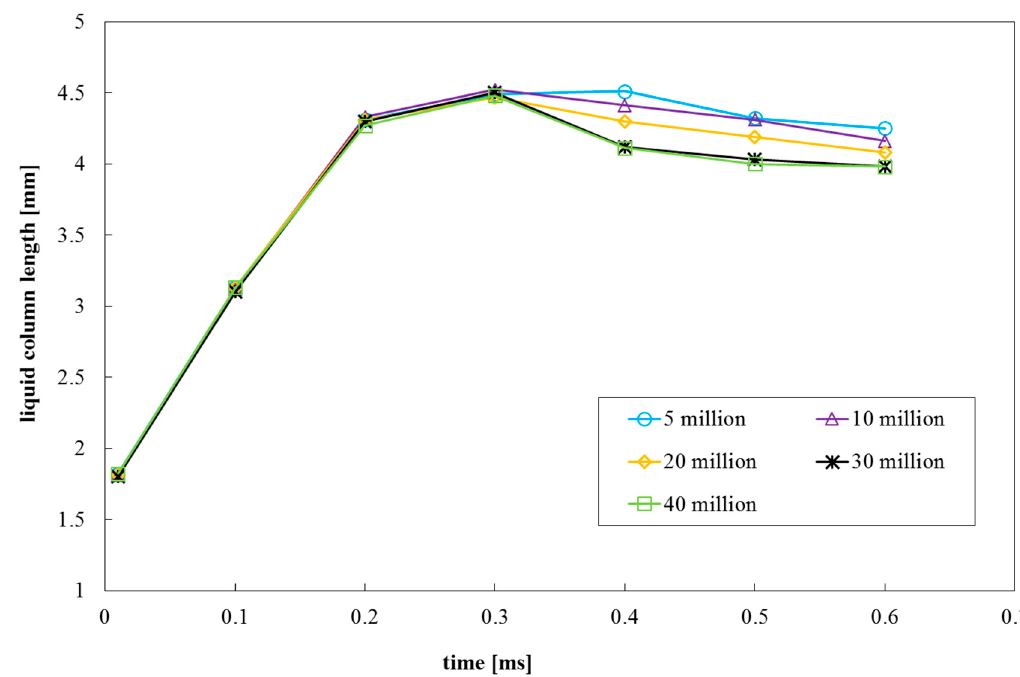
Figure 4. Dependence of results on number of grid points.